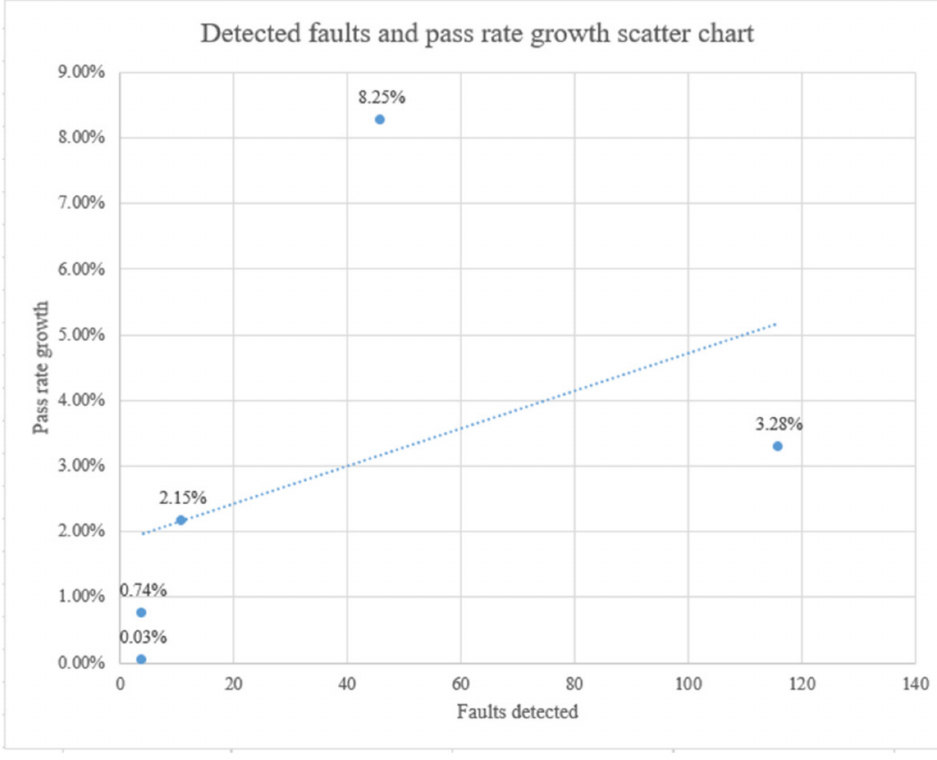
Figure 40. Scatter chart to detect faults and pass-rate